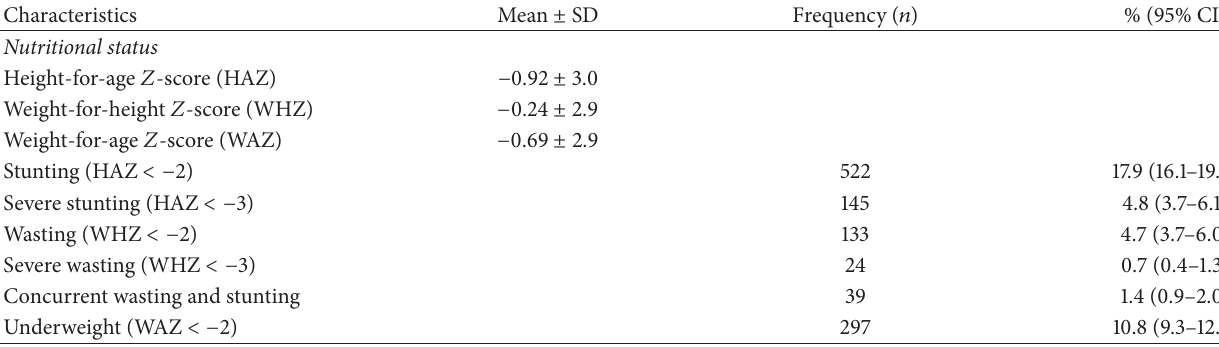
Table 2: Prevalence of malnutrition among children aged 0–59 months ( 𝑁 = 2 , 720 ).